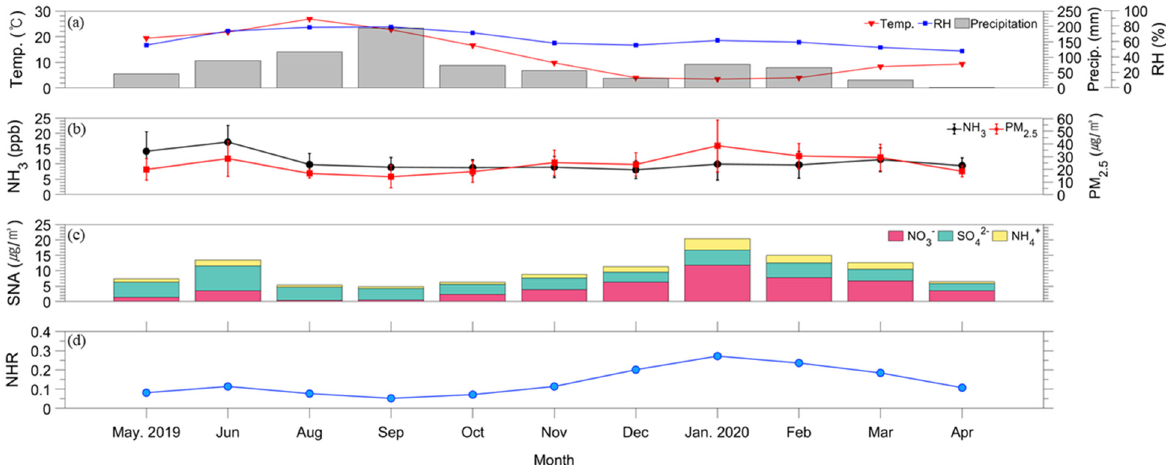
Figure 4. Monthly variations in ( a ) meteorological parameters, ( b ) NH 3 and PM 2.5 concentrations, ( c ) SO 42 − , NO 3 − , and NH 4+ (SNA) concentrations in PM 2.5 , and ( d ) the ratio of NH 4+ to total NH 3 (NHR) from May 2019 to April 2020.